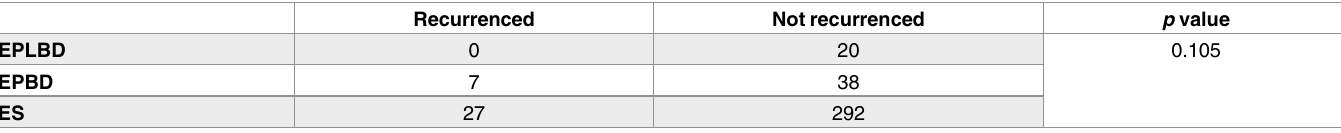
Table 4. The recurrencerate depended on the each treatment (Marasculio